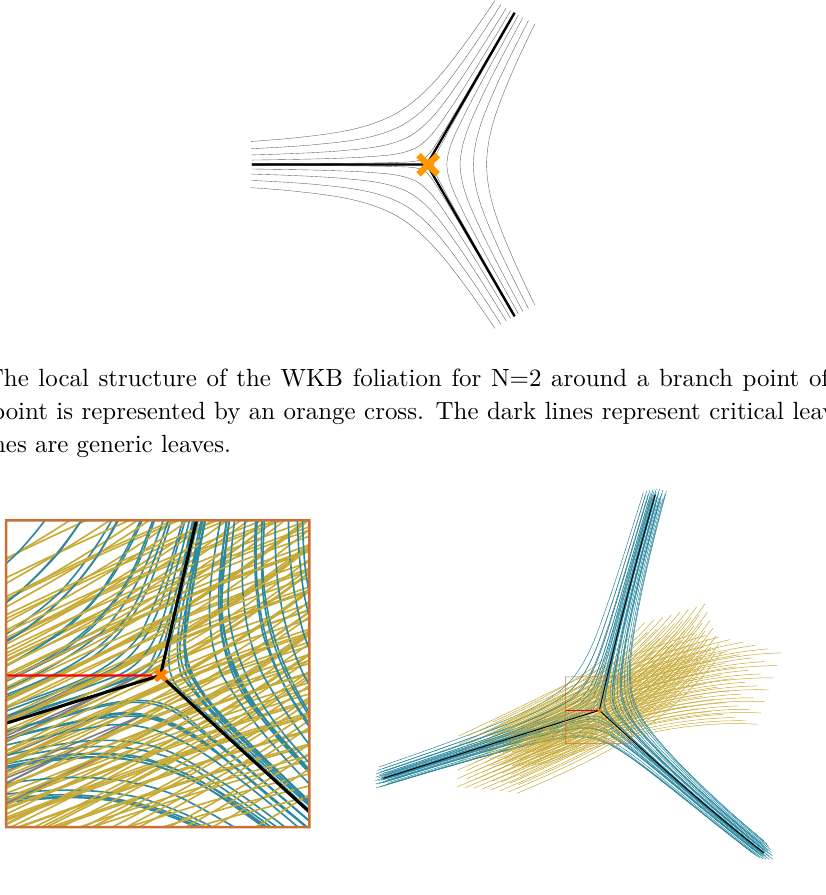
Figure 9 . Left: the WKB foliations near a simple branch point when N = 3 . The branch point is the orange cross in the center of the figure. The three black curves emanating from the branch point are the critical leaves. The red line marks the “caustic” where the three local foliations become tangent. The blue and yellow leaves were generated by fixing a 7 by 8 rectangular grid of points, drawing the three leaves through each of these 56 points, then coloring them blue or yellow according to their ij -types. Right: a zoomed-out view showing the larger-scale behavior of these leaves.